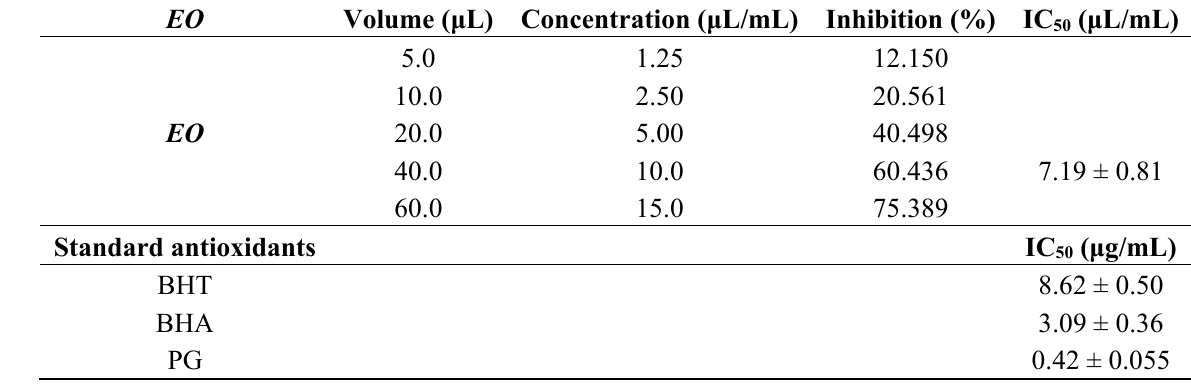
Table 2. DPPH-radical scavenging capacity (RCS) of Eucalyptus gunnii essential oil ( EO ) and BHA, BHT and PG as positive